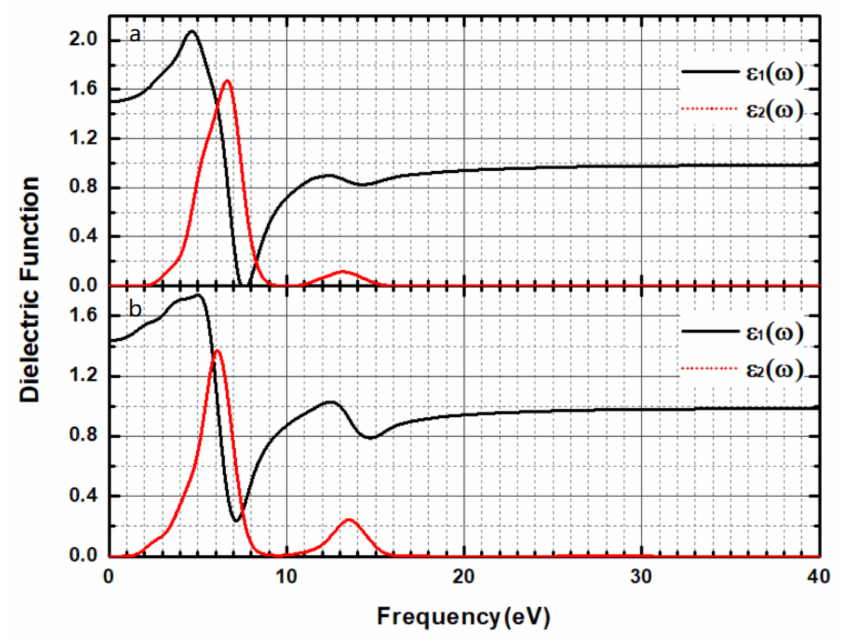
Figure 11. (Color online) Dielectric Function of the CsI(Na) (010) surface ( a ) and that of the CsI(Na) (010) surface adsorbing H 2 O molecules ( b